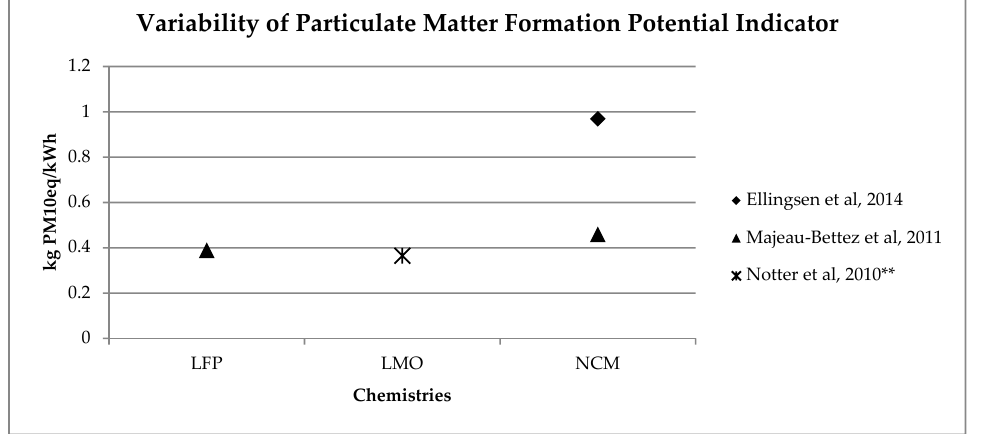
Figure 6. Variability of particulate matter formation potential (kg PM10eq/kWh) for batteries production phase (LFP: Lithium iron phosphate; LMO: Lithium Manganese Oxide; NCM: Lithium Nickel Cobalt Manganese Oxide); ** data from reference [11] have been updated using Ecoinvent v 3.5. Table 4. E ff ects of the variability of acidification potential (g SO 2 eq) and eutrophication potential (g PO 4 eq) per kWh of battery on the life cycle comparison among a middle size electric, diesel and petrol car. Battery Emissions per km derives from Figures 3 and 5, considering 40 kWh of capacity and 210,000 km of life. Emissions per km of remaining life cycle phases are taken from reference [1].